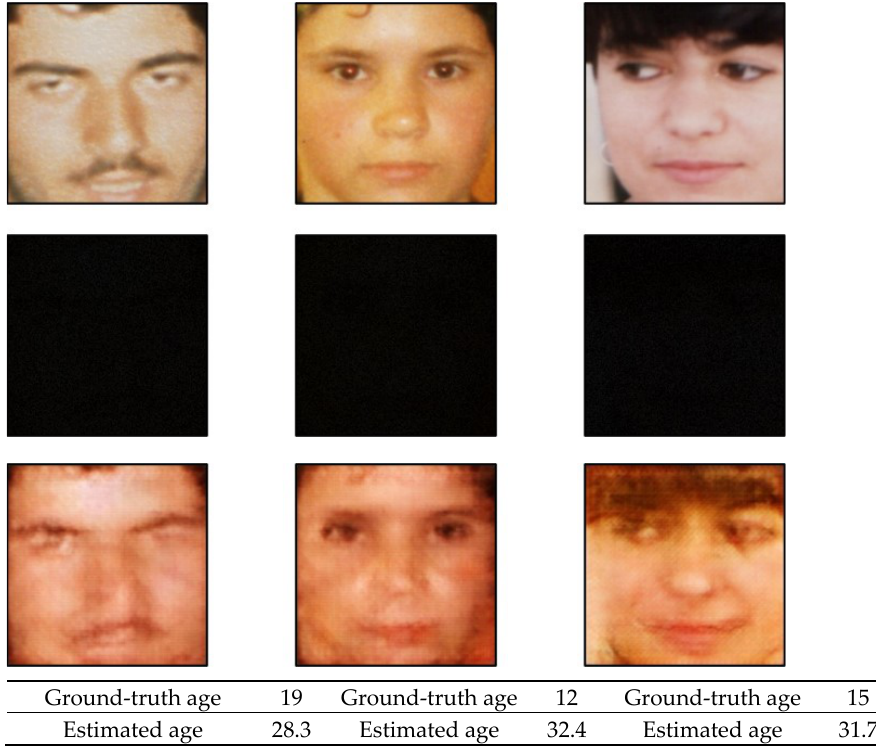
Figure 14. Bad cases of age estimation by the proposed method. The 1st, 2nd and 3rd rows show the original images, low-illuminated images, and the images enhanced by LAE-GAN, respectively.